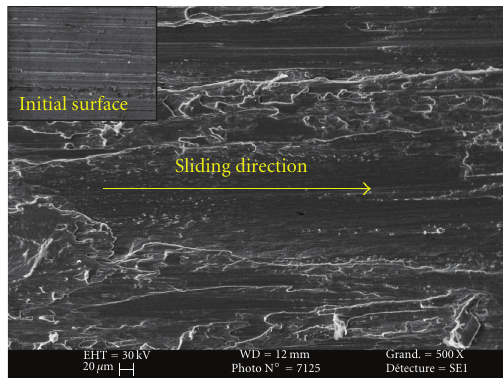
Figure 7: SEM photographs (magnitude × 500) after friction, V = 20m / s,P a =